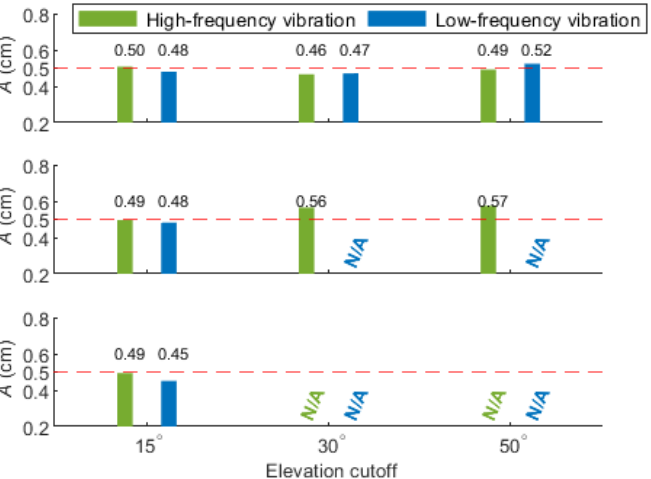
Figure 16. Amplitudes of the vibrational behaviors at levels of masking conditions. The five-con- stellation PPP is adopted during the process. The top, middle and bottom panels refer to the E, N and U directions, respectively.